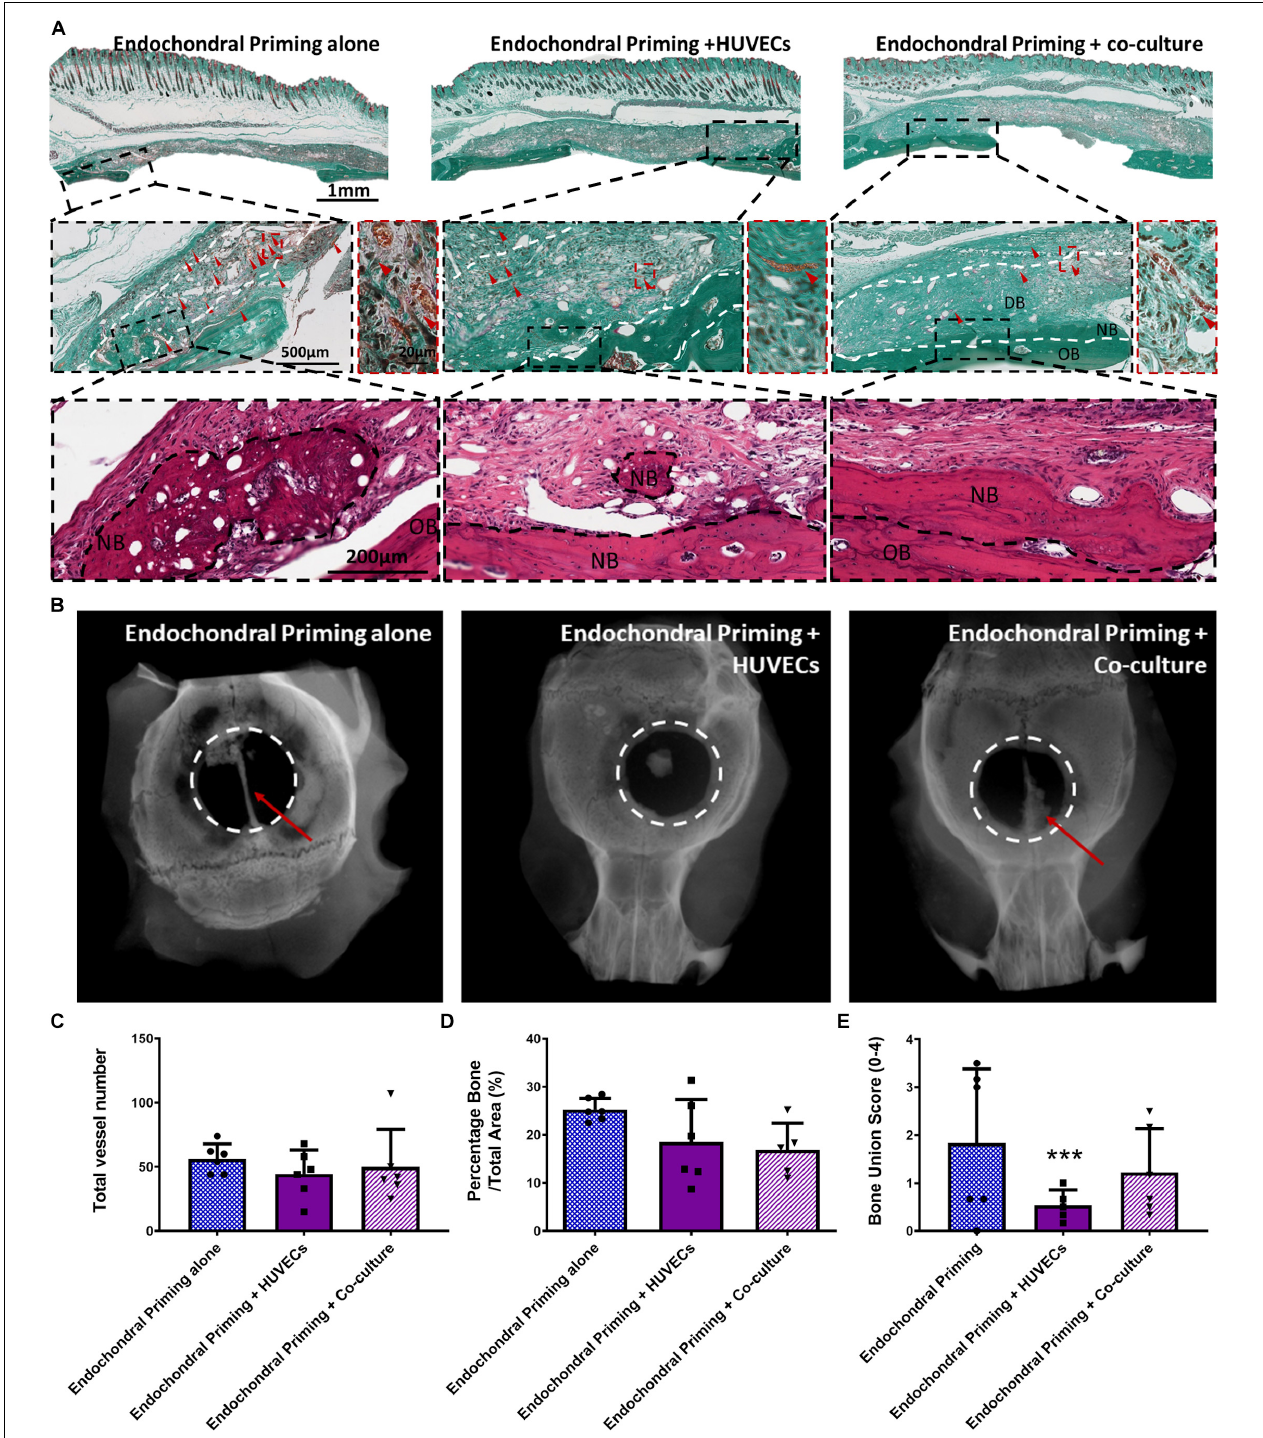
FIGURE 3 | (A) Masson’s Trichrome and H&E stained sections of all groups taken in the middle of the defect after 8 weeks in vivo. All Images taken at 20X. White dashed lines denoting periphery and centre, OB denoted original bone, and NB denotes new bone. Red arrow heads denote vessels. (B) Representative X-ray images of the three experimental groups 8 weeks after implantation. Quantification of the amount of panel (C) total number of vessels, (D) percentage new bone, and (E) bone union score for all three experimental groups 8 weeks post implantation. Error bars denote standard deviation, *** p < 0.01 vs. Endochondral Priming alone group, n = 6